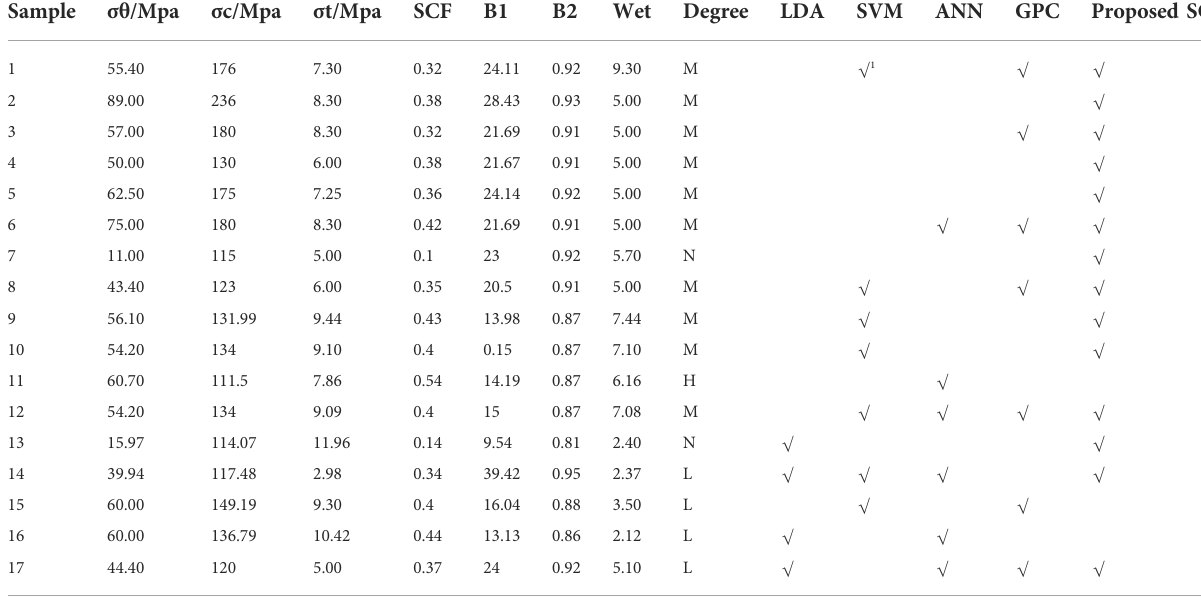
√ 1 represents this algorithm made a correct judgment of intensity degree for this